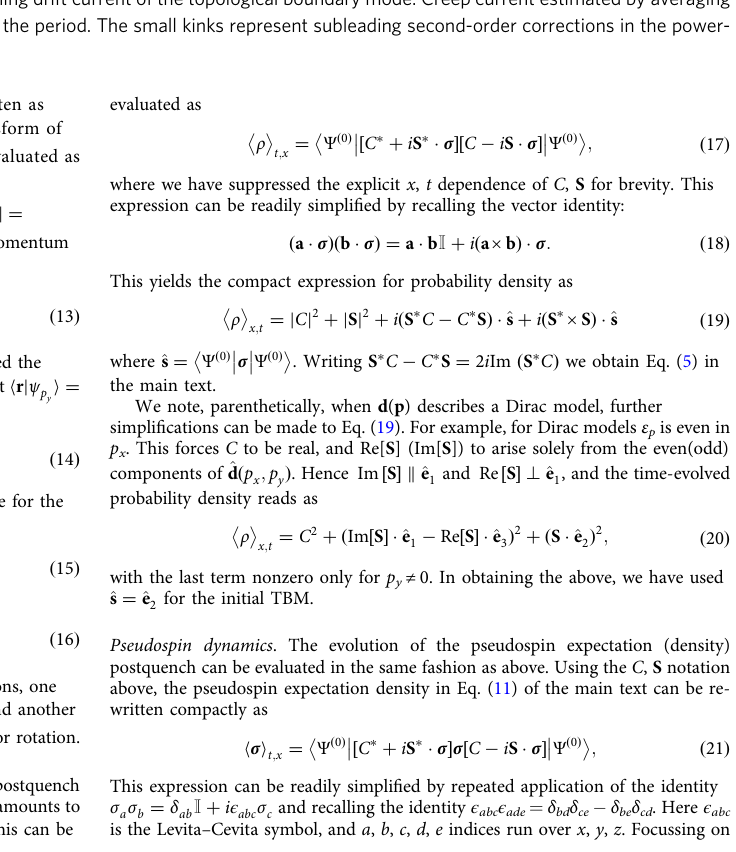
(cid:6) (cid:4) (cid:6) (cid:4) and σ y